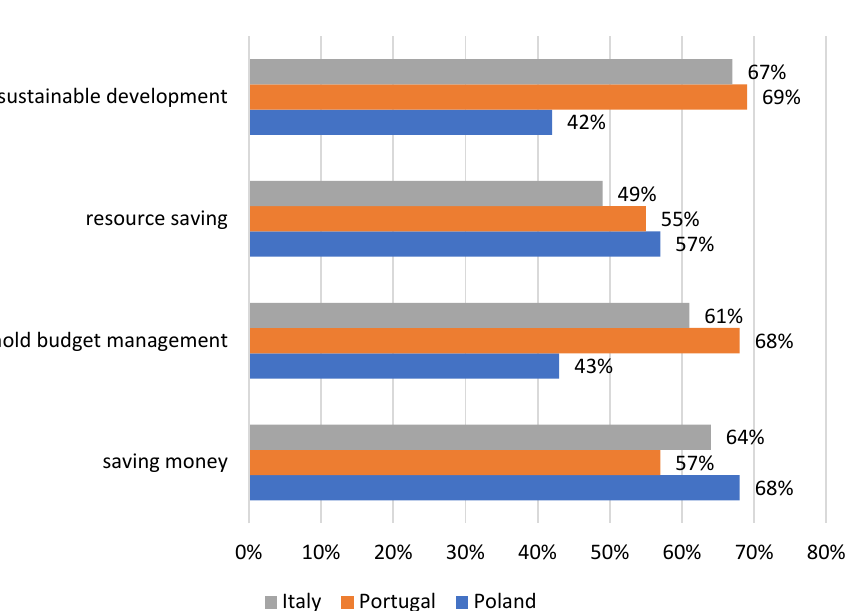
Figure 2. Energy saving methods.